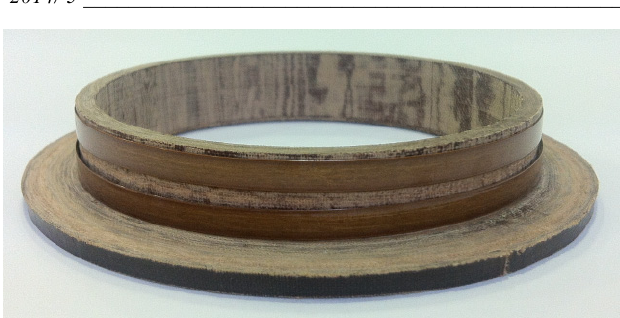
Fig. 3. View of the secondary, built by two first generation superconducting tapes wrapped around a Celeron holder.